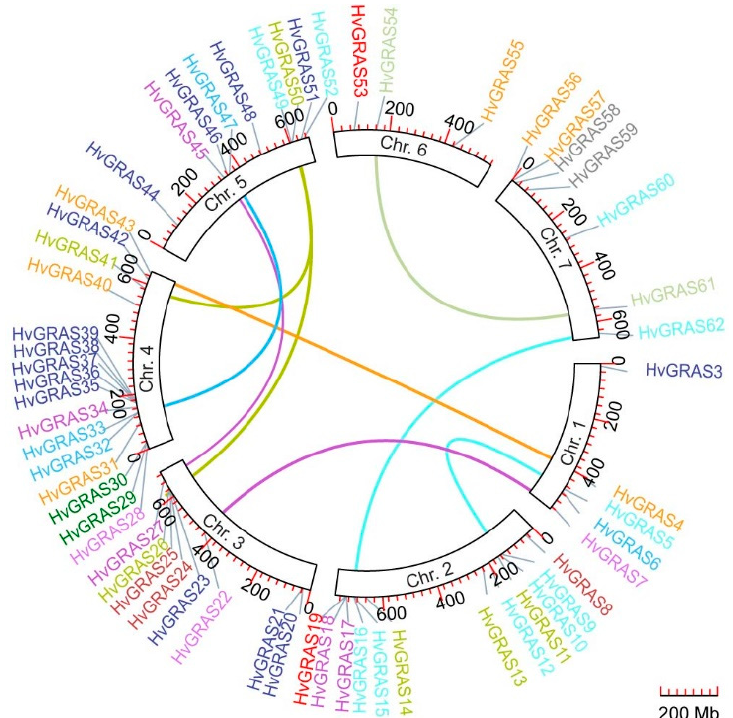
Figure 2. Chromosomal localization of HvGRAS genes and gene duplications. The locations of HvGRAS genes are based on the physical position. The black letters indicate chromosome number. Colorful lines and neighboring HvGRAS genes in same color indicate duplication.